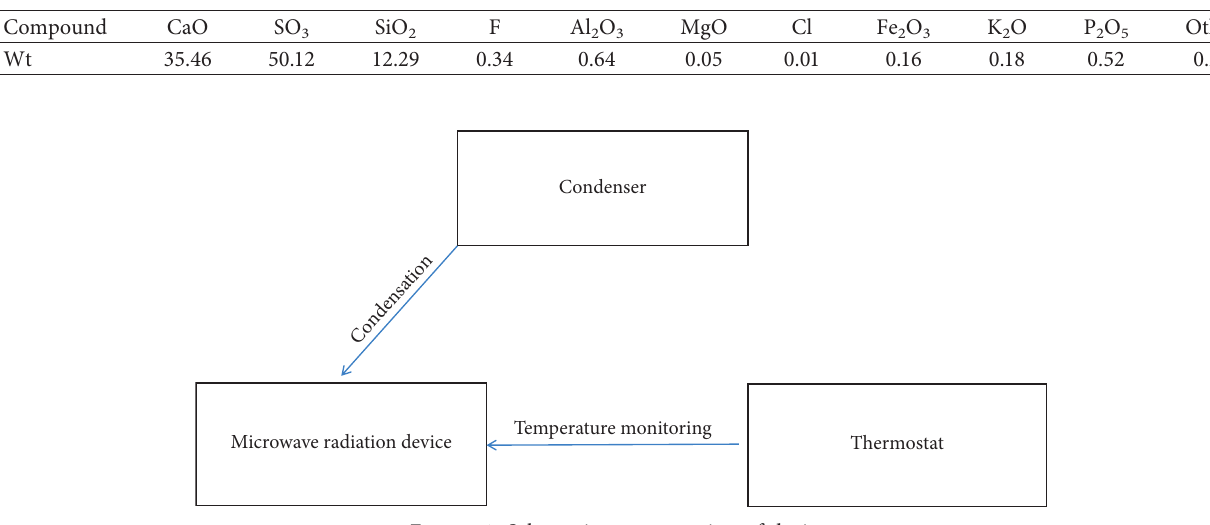
Figure 1: Schematic representation of device.